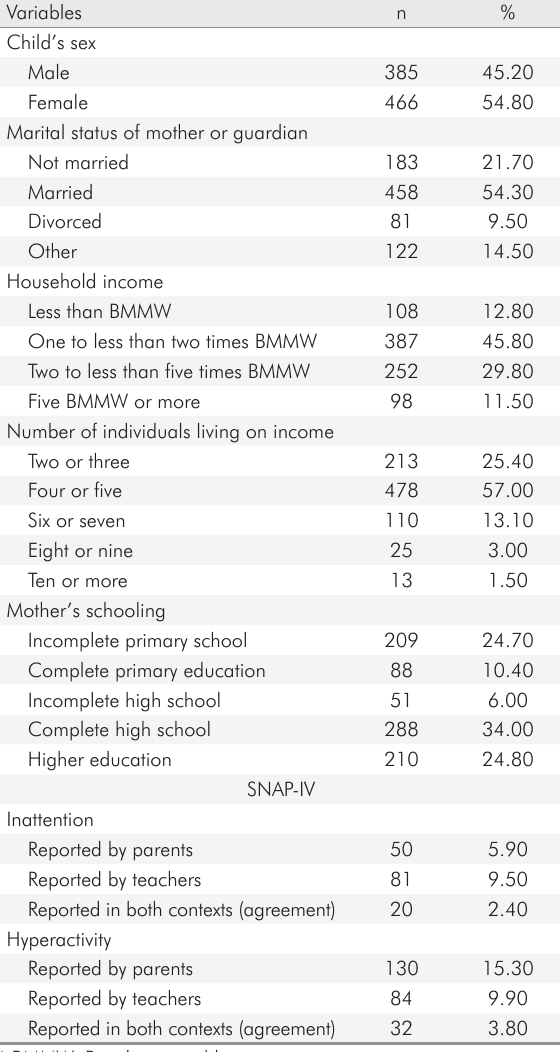
Table 2. Frequency of socioeconomic and neuropsychological variables.